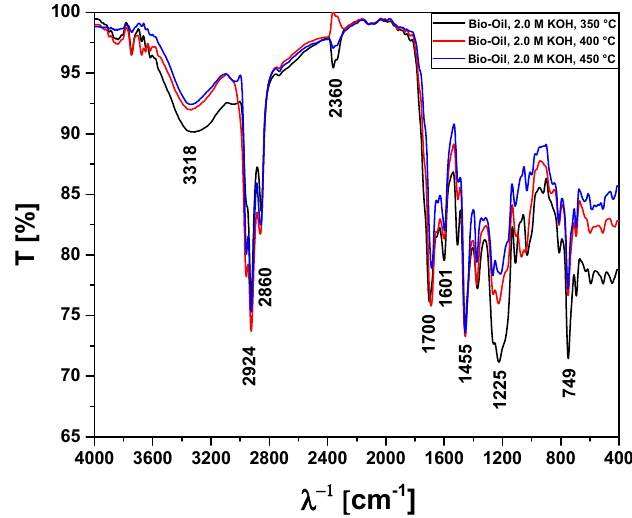
Figure 6. Acidity of bio-oil obtained by pyrolysis of Açaí seeds, activated with 2.0 M KOH solution, at 350, 400, and 450 °C, 1.0 atmosphere, in laboratory scale.